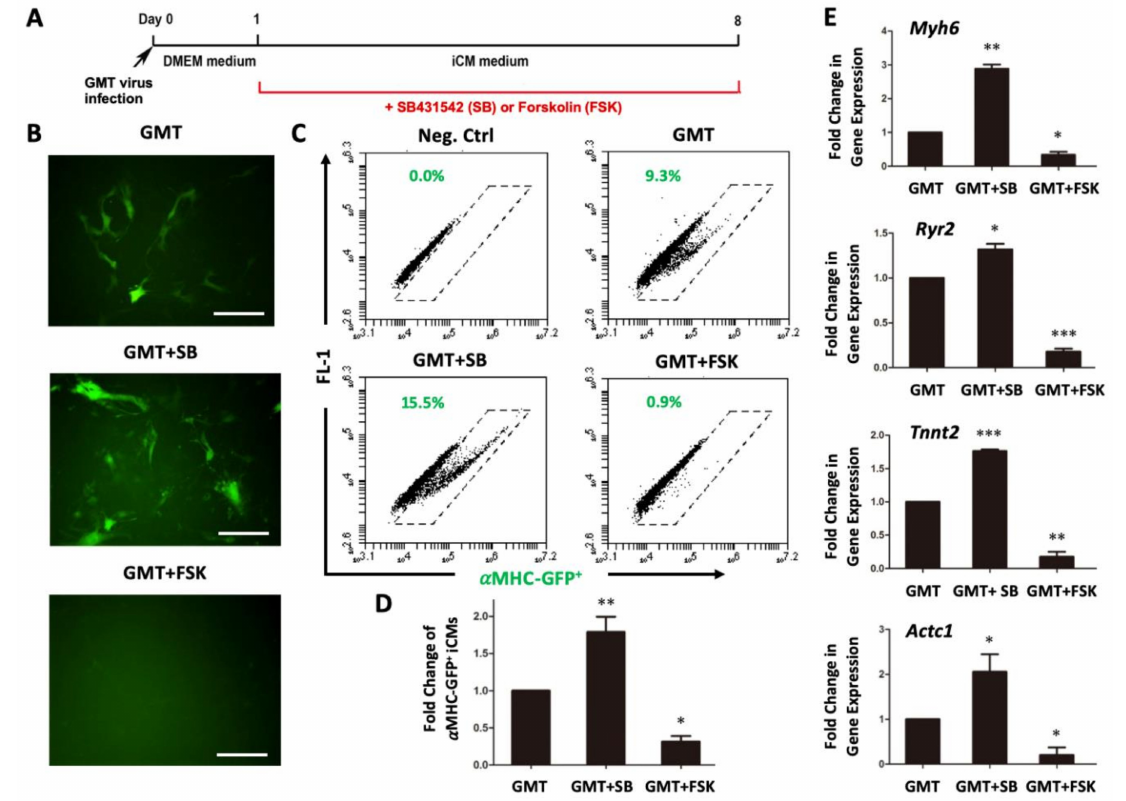
Figure 3. Post-induction treatments of SB431542 (SB) and forskolin (FSK) have opposite effect on iCM reprogram- ming of tail-tip fibroblasts (TTF). ( A ) Experimental strategy of post-induction treatment during iCM reprogramming. ( B – C ) Representative fluorescent images ( B ) and FACS plots ( C ) of iCM reprogramming at Day 8 after infection. Bars indicate 50 µ m. ( D ) Average fold changes of reprogrammed α MHC-GFP + iCMs by SB431542 and FSK. ( E ) Fold changes of cardiac gene expression in reprogrammed fibroblasts, including Myh6 , Ryr2 , Tnnt2 , and Actc1 . * p < 0.05, ** p < 0.01, or *** p < 0.001 vs. GMT